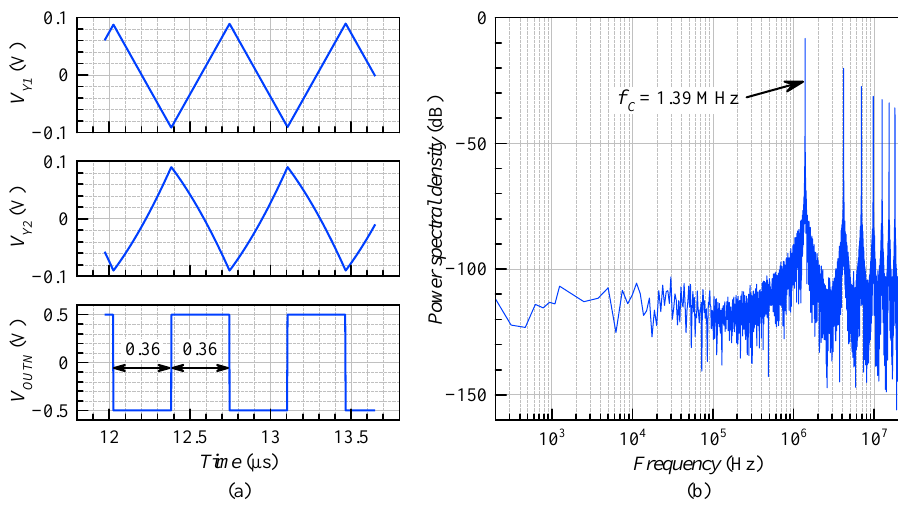
Figure 5. MATLAB model simulation results: ( a ) timing diagram and ( b ) frequency spectrum of the ADSM for V IN = 0